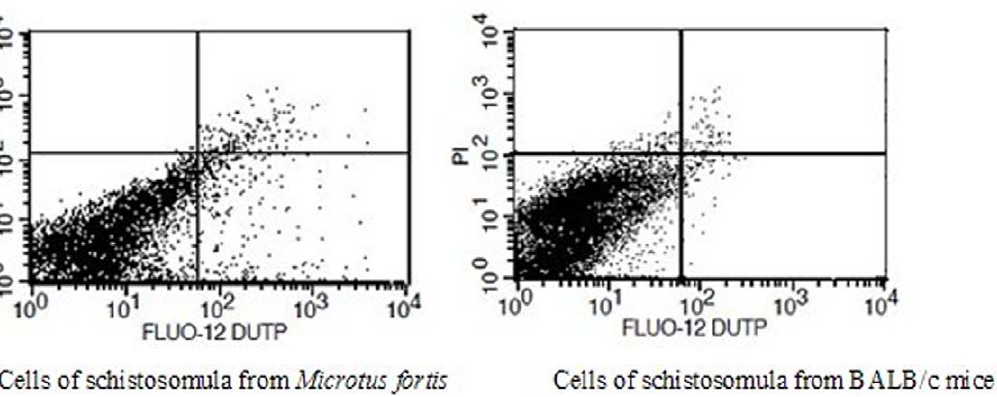
Figure 9. Tunnel analysis of cells of schistosomula taken from BALB/c mice (right panel) and Microtusfortis (left panel). The lower left quadrants refer to intact cells (FLUO-12UTP 2 PI 2 ); the lower right quadrants represent apoptotic cells (FLUO-12UTP + PI 2 ); the upper right quadrants refer to necrotic cells (FLUO-12UTP + PI + ). The data shown are representative of three independent experiments.